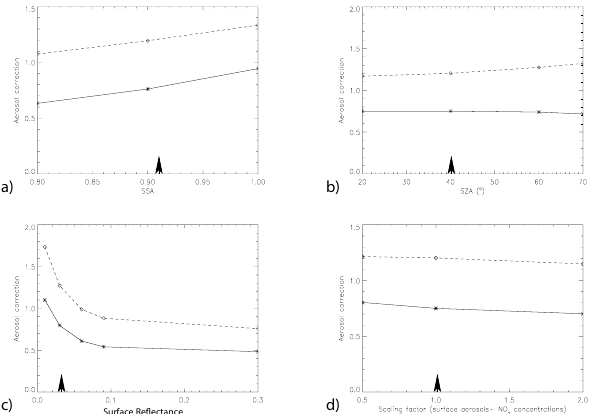
Figure 4. Aerosol correction factor sensitivity to (a) single scat- tering albedo, (b) solar zenithal angle, (c) surface reflectance, and (d) emissions (aerosol and NO 2 surface concentration rescaling). Solid and dashed lines correspond to the case with and without the elevated aerosol layer, respectively. For each parameter, the arrow indicates the value corresponding to the reference